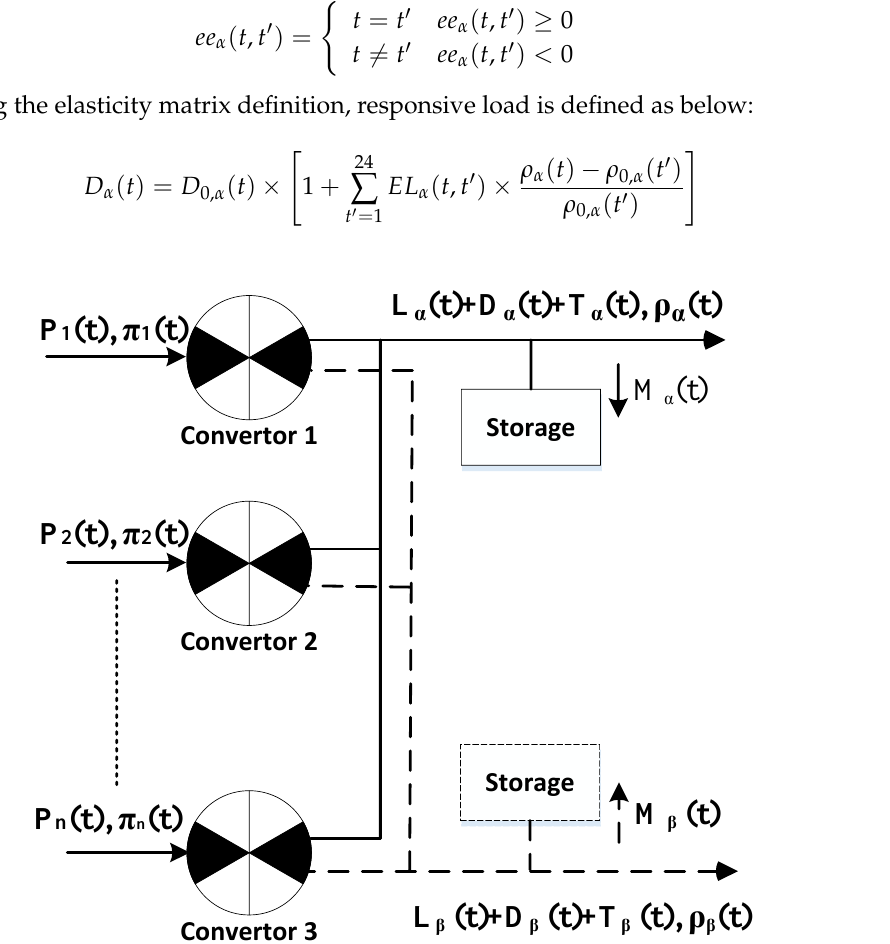
Figure 2. Diagram of correlation between input and output carriers and energy prices.